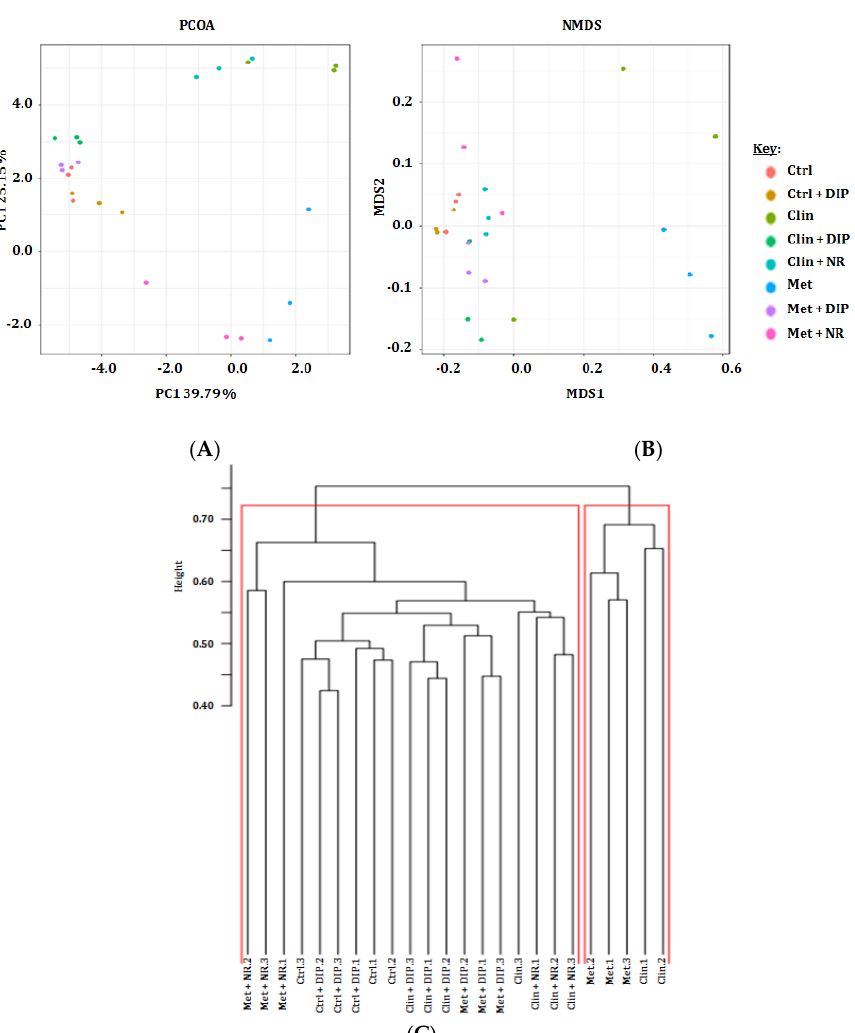
Figure 4. The representative graphical output of the beta diversity indices. ( A ) Principal coordinate analysis (PCoA) plot, ( B ) Non-metric multidimensional scaling plot (NMDS) with Bray–Curtis dissimilarity showing the distribution of the mice fecal samples based on the phylogenetic makeup of their microbiota. Each sample is represented by a dot in the graph, while different treatment groups are represented by different colors ( n = 3). The distance between the points represents the level of difference; the closer the samples are, the higher the similarity between them. ( C ) Hierarchical cluster dendrogram representing similarities or dissimilarities between different treatment groups ( n = 3 per group). Distance is shown on the scale